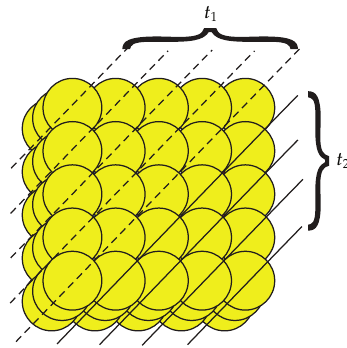
Figure 18: Refined plane partitions which count D6-D0 bound states in C 3 . In each slice balls, which intersect a dashed or solid line, have, respectively, weight t 1 or t 2 . The resulting generating function is the refined MacMahon function M ref (cid:4) t 1 ,t 2 (cid:5)